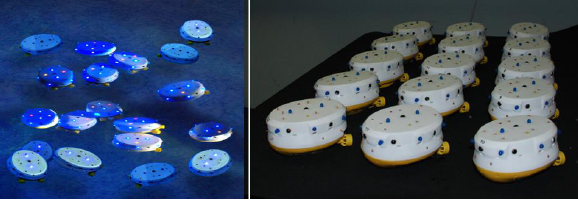
Figure 8: Collective Cognitive robots of the Artificial Life Labora- tory of Graz, Austria. A swarm of autonomous underwater vehicles (AUVs) that are able to interact with each other and which can bal- ance tasks (interactions between/within